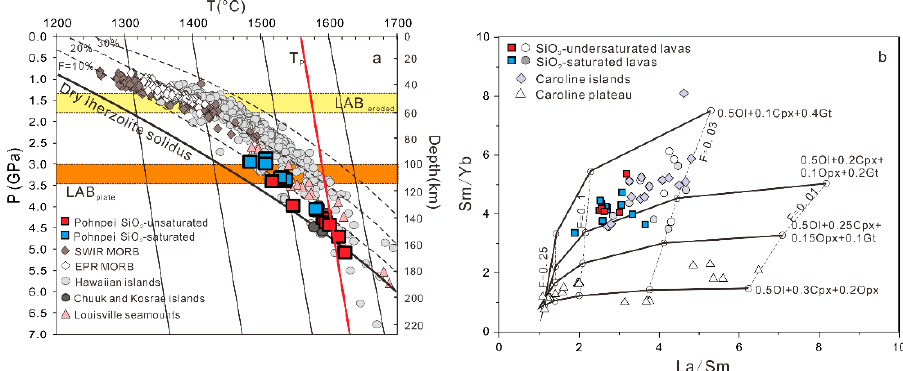
Figure 8. ( a )Temperatures and pressures calculated for Pohnpei lava, based on the model of Lee et al. [47]. Lherzolite solidus and melt fraction isopleths are from Katz et al. [55]. Curved lines represent adiabatic melting conditions; near-vertical lines (gray and red) represent solid-mantle adiabatic conditions. Hawaiian Island basalt data are from Lee et al. [47]; Southwest Indian Ocean Ridge (SWIR) and East Pacific Rise (EPR) MORB data from Gale et al. [39]; Chuuk and Kosrae Island basalt data from Jackson et al. [10]; and Louisville Seamount basalt data from Beier et al. [56] and Vanderkluysen et al. [51]. Basalts with MgO contents of >9 wt.% were corrected to olivine Fo 90 following the method of Lee et al. [47]. ( b ) (Sm/Yb)–(La/Sm) plot based on the model of Zhang et al. [13] and references therein. Abbreviations: Ol, olivine; Cpx, clinopyroxene; Opx, orthopyroxene; Gt, garnet.